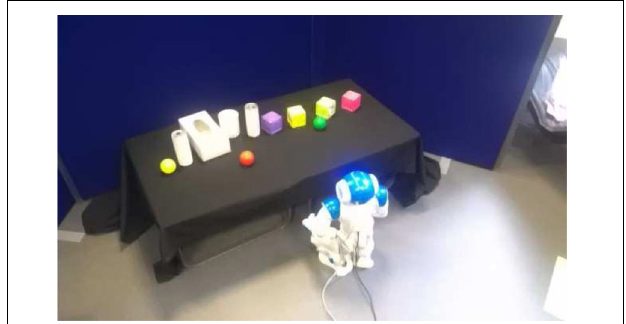
FIGURE 7 | The more complex environment used in the second set of tests of the robot profiles. More objects that vary in shapes and sizes were placed on the table.